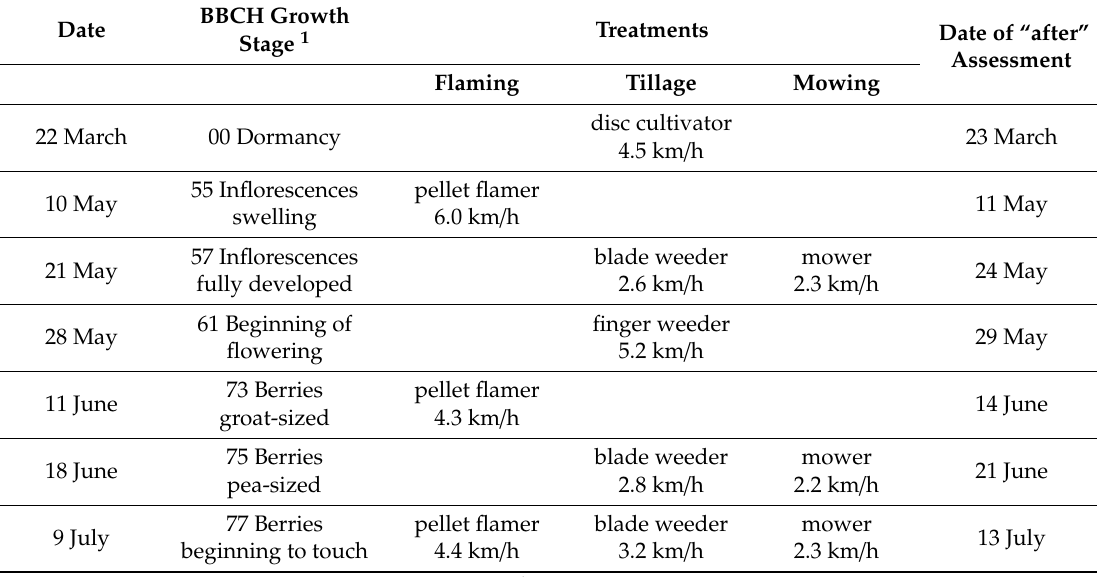
Table 1. Treatment dates, growth stages of the vines, implements used and dates of “after”